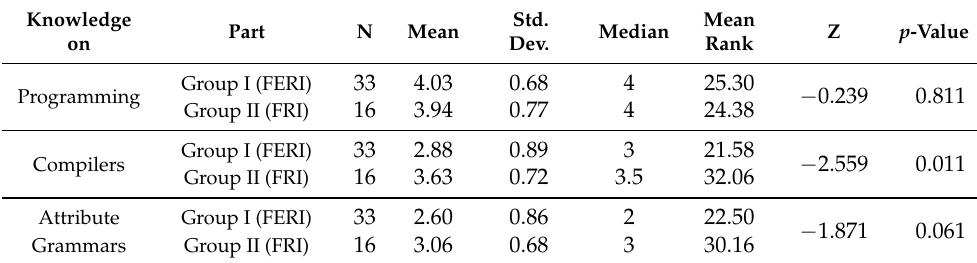
Table 1. Background study on knowledge (Mann–Whitney test).